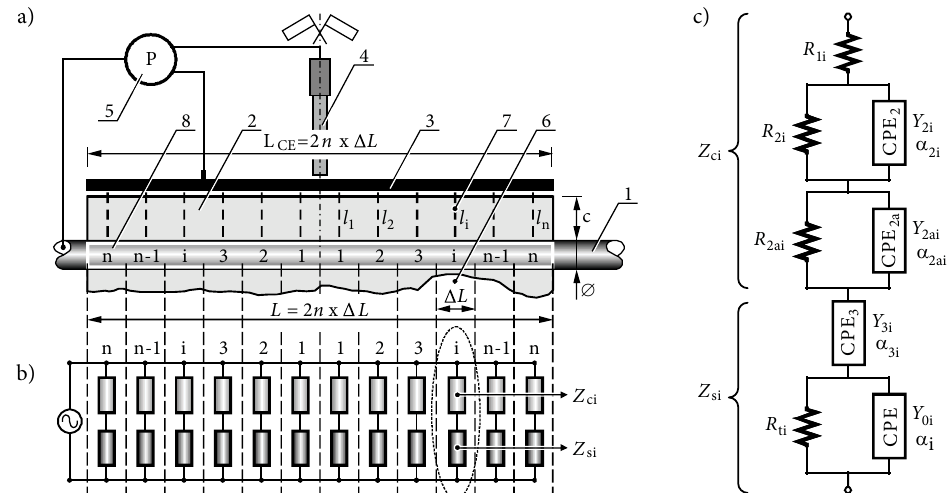
Fig. 5. Model of steel-concrete system to simulate the influence of the length of reinforcing bar in concrete and the area of the counter electrode on the shape of impedance spectra